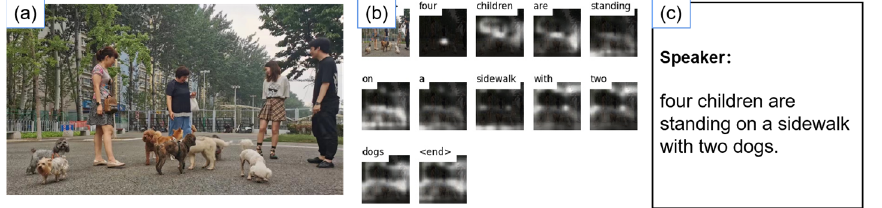
Figure 20. Image processing results of a park scene. ( a ) Processed images. ( b ) Processed results. ( c )